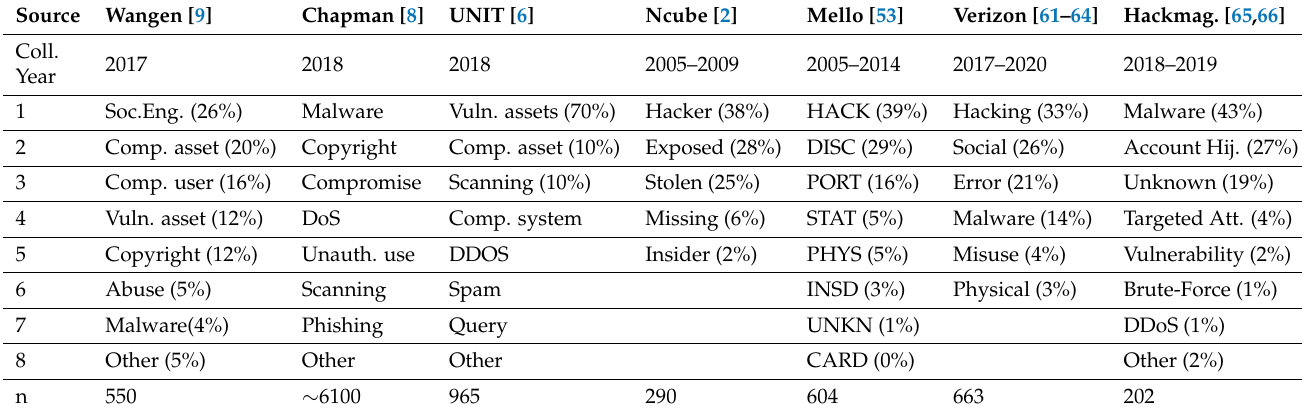
Table 11. The rank of the threat events present in the educational industry according to the